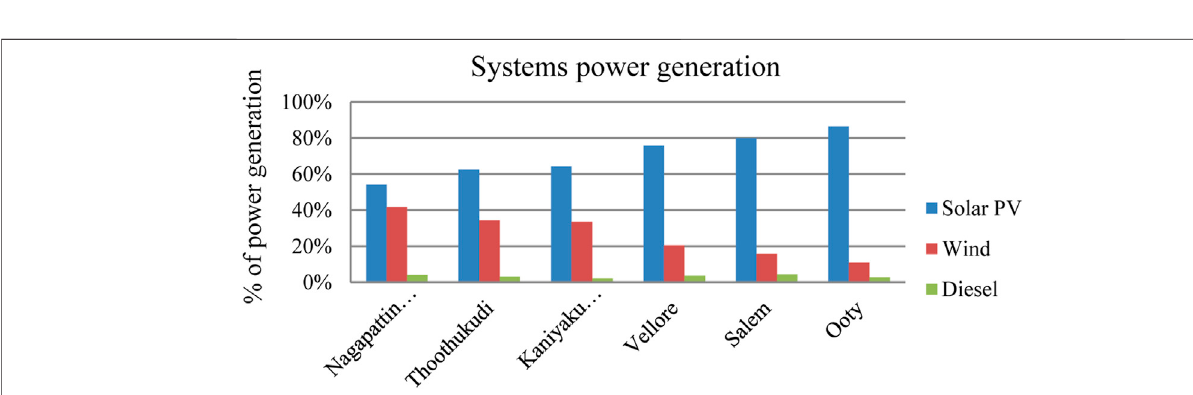
FIGURE 11 | Monthly electricity production from solar, wind, and diesel generators (Thoothukudi).